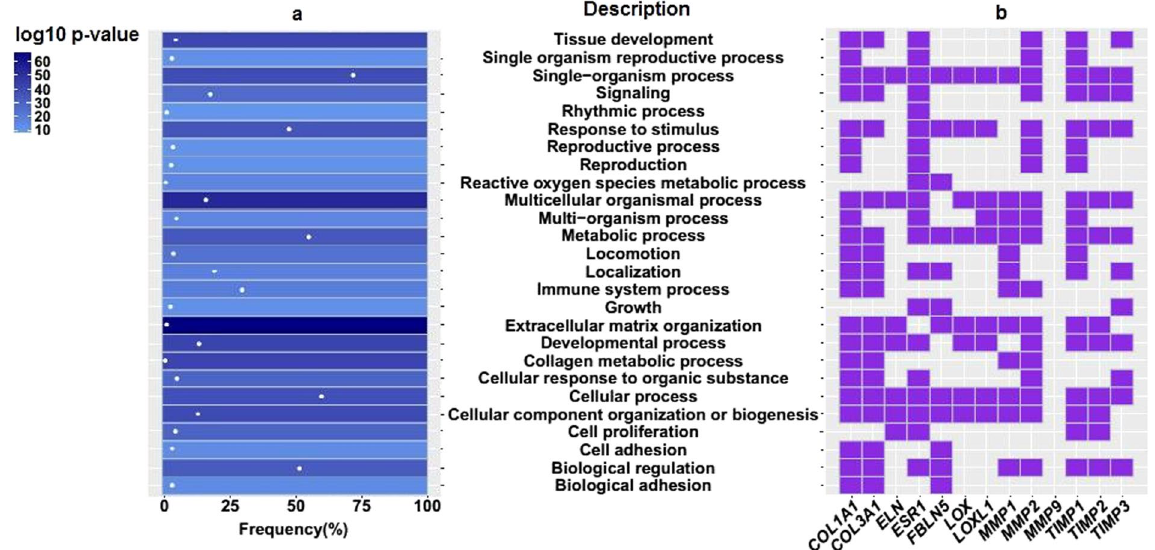
Figure 2. ( a ) Heat map for GO terms cluster representatives for genes considered in POP studies. ( b ) GO terms associated with the selected genes. Color indicates the user-supplied P- value; the term ‘frequency’ means frequency of the specific term in the underlying GO annotation